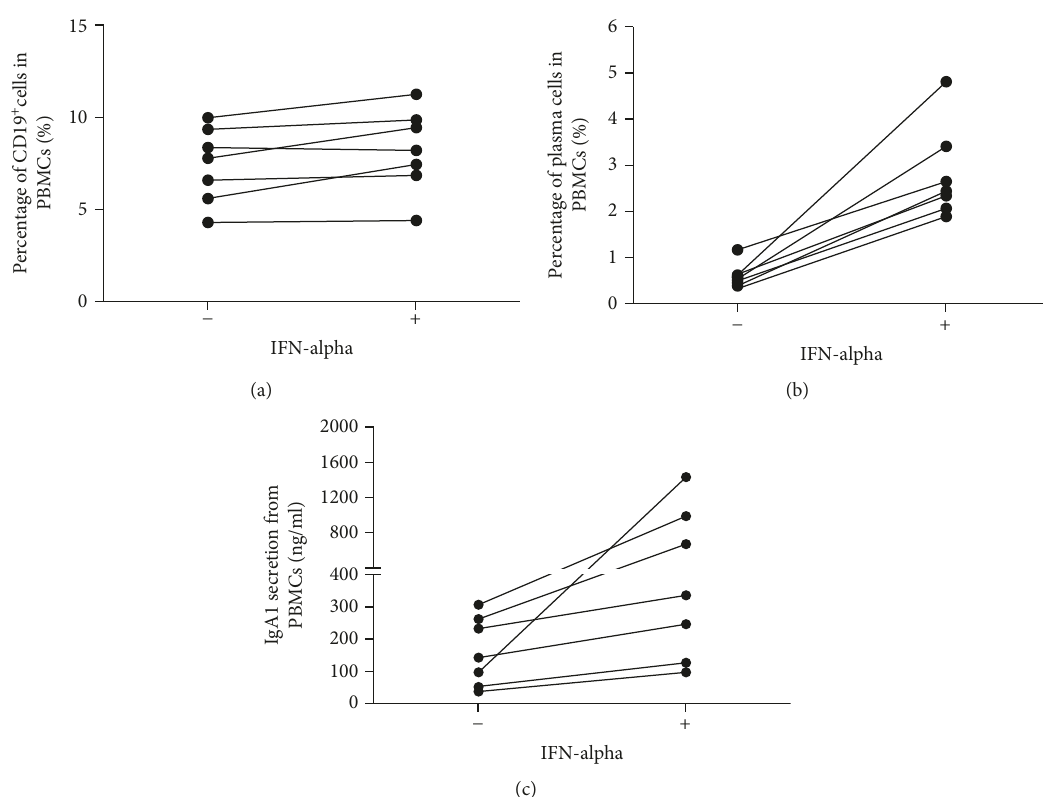
Figure 5: IFN- α promote the di ff erentiation of plasma cells from PBMCs ex vivo. PBMCs of di ff erent healthy donors ( n = 7 ) were prepared by fi coll-paque density centrifugation and cultured with or without IFN- α (2000IU/ml) plus anti-IgM antibody for 6 days, followed by surface markers labeling and analysis in fl ow cytometry. (a) The percentage of CD19 + cells in PBMCs after IFN- α treatment for 6 days. (b) The percentage of plasma cells in PBMCs after IFN- α treatment for 6 days. (c) IgA1 secretion from PBMCs after IFN- α treatment for 6